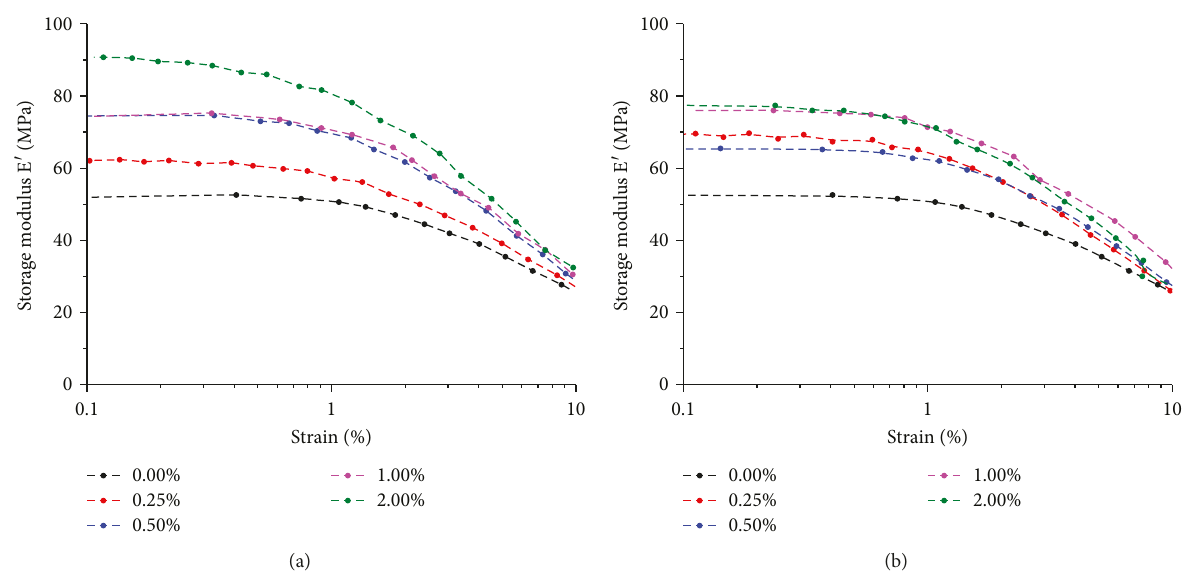
Figure 18: Storage modulus ( E ′ /MPa) versus strain (%) for nanocomposites (a) PU40-GNP and (b)